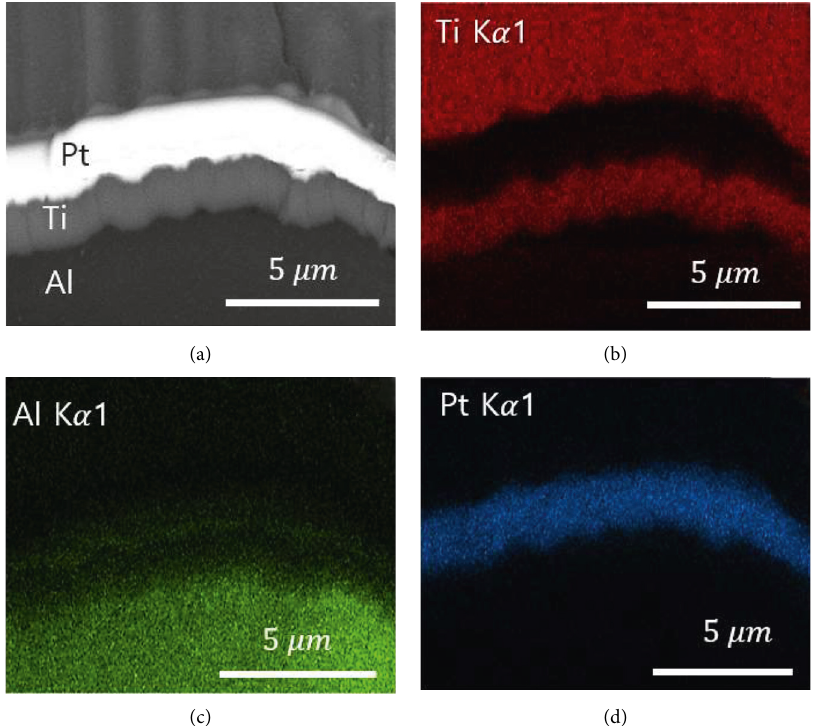
Figure 3: EDS mapping image of the interface: (a) cross-sectional view of sample; (b) Ti layer; (c) Al layer; (d) Pt